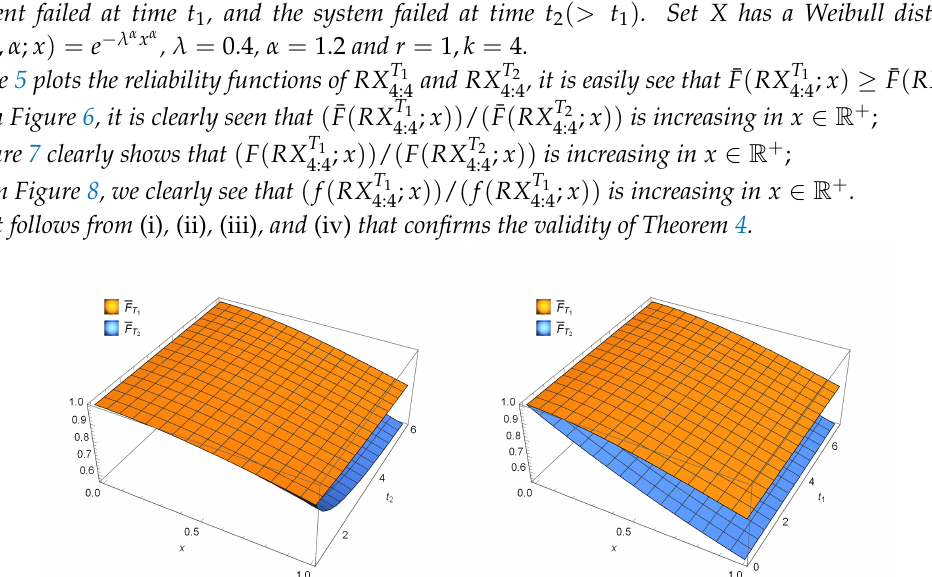
Figure 5. The graphs of the reliability function of RX T 1 t 2 = 8 ( right ).